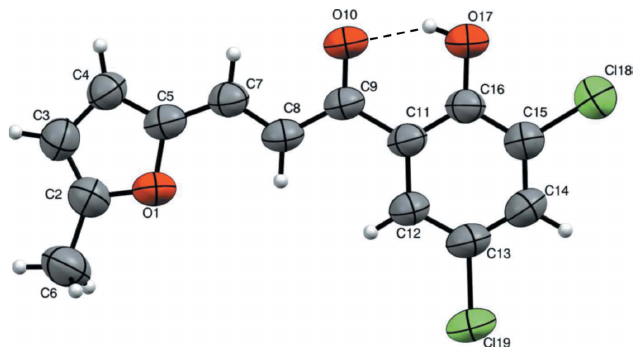
Figure 1 The molecular structure of the title compound, with atom labelling and 50% probability displacement ellipsoids. The intramolecular hydrogen bond (Table 1) is indicated by a dashed line.